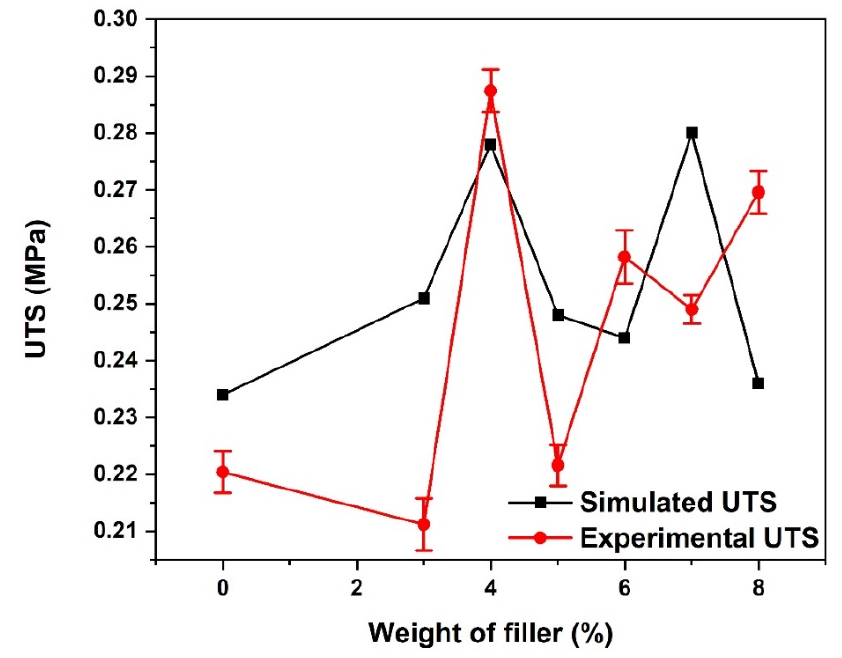
Figure 5. Ultimate tensile strength of CCP-PLA nanofibre.